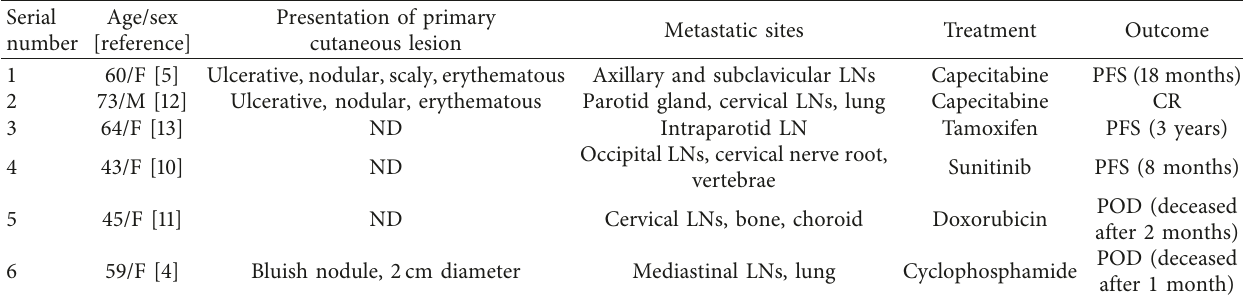
Table 1: Demographics, presentations, treatments, and outcomes of reported cases of metastatic